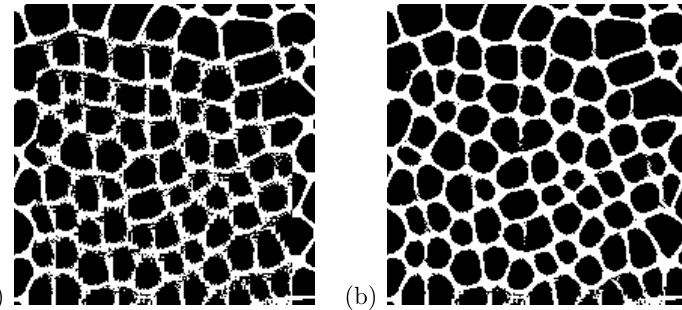
Figure 4. Effect of the smoothing network based on the non-causal model: (a) reconstructed image serving as an input, (b) microstructure corrected by the smoothing model. Both images are of size 200 x 200 pixels.